Question: Name the type of graph shown.
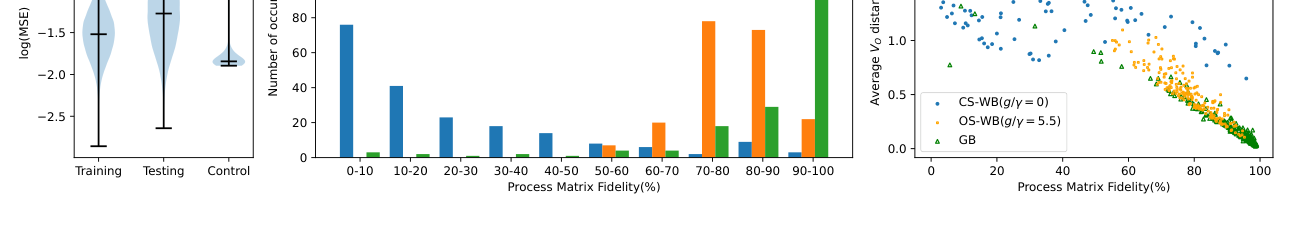
Answer: box